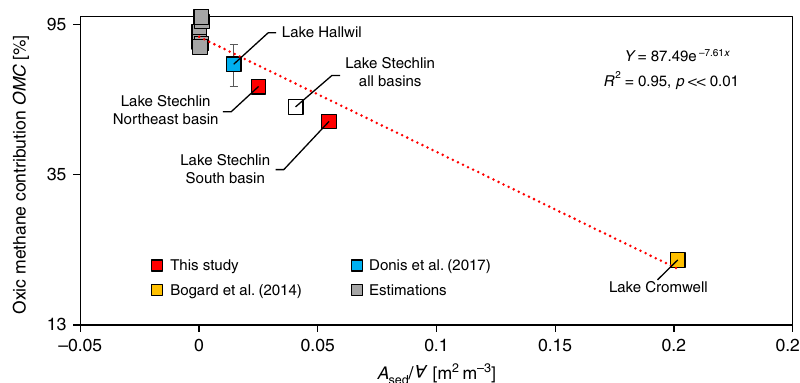
Fig. 4 Oxic methane contribution versus lake morphology. The ratio of sediment area ( A sed ) and surface mixed layer volume ( ∀ ) determines the oxic methane contribution to surface emission ( OMC ). The trend line (red line) follows the exponential function y ¼ 87 : 49 e (cid:2) 7 : 61 x ( R 2 = 0.95, p ≪ 0.01, standard error = 8.6%). The y -axis is scaled to log 2.7 and the x -axis is linear. With increasing lake size, ∀ increases quicker than A sed making oxic methane production the largest source of surface mixed layer methane in lakes with A sed / ∀ ≤ 0.07 m 2 m − 3 . Lake Hallwil estimation 21 was updated as described in Supplementary Note 1; the lower and upper end (error bars) were used to compute the mean OMC which was used for developing the trend line function. Estimations for other lakes were computed as de fi ned in Supplementary Note 3. If whole lake data (combining South and Northeast basin data) was to be applied to this empirical model (empty symbol) the regression constants and statistics only change minimally ( y ¼ 88 : 48 e (cid:2) 7 : 56 x ; R 2 = 0.96, p ≪ 0.01). Source data are provided as a Source Data fi